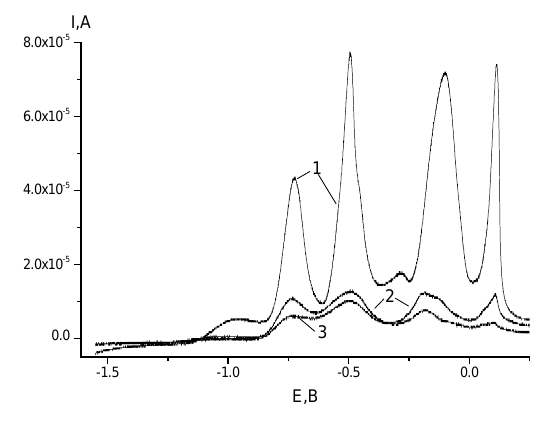
Fig. 2. Stripping voltammograms showing the effect of lacrimal fluid and Betoftan on the test system on the test system: (1) test system, (2) lacrimal fluid, (3) tear fluid after instillation of Betoftan.